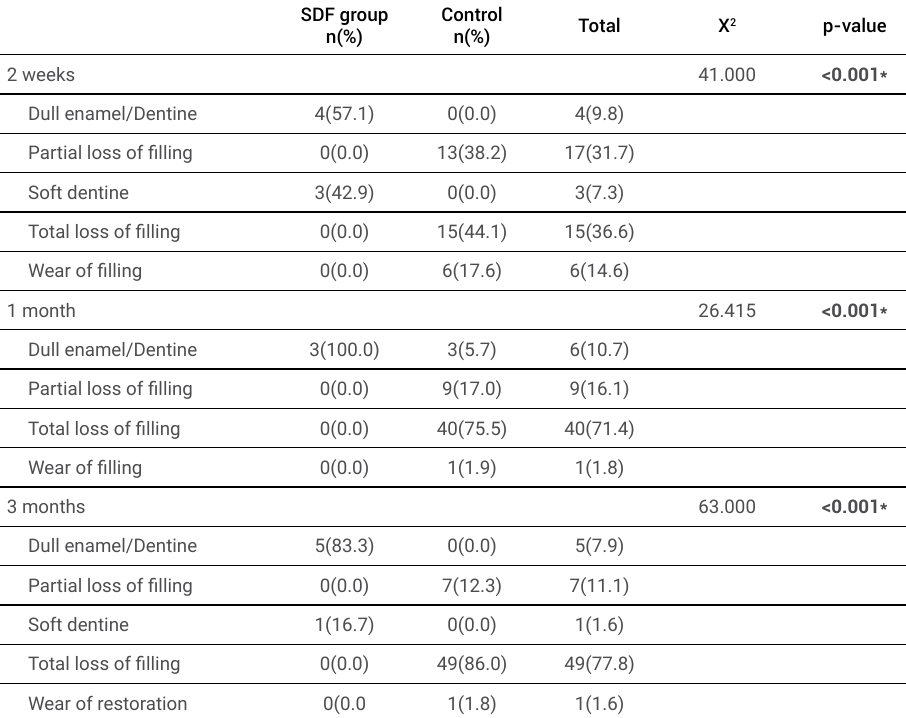
Table 3. Distribution of intervention failure at different intervals of assessment SDF group